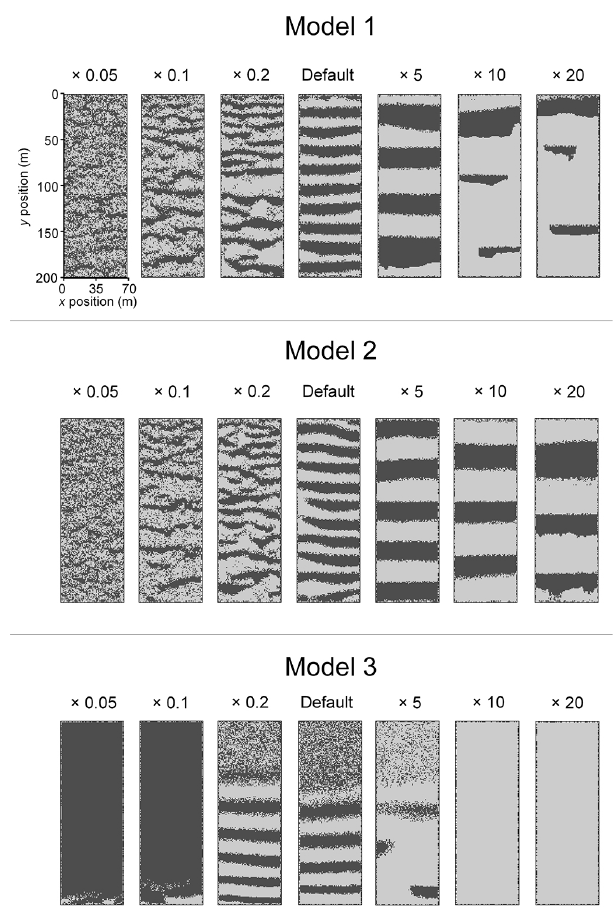
Figure 8. Final micro-habitat maps after 100 developmental steps, showing e ff ects of di ff erent combinations of T hum and T hol (in the case of Model 1, top panel) or K hum and K hol (Model 2, middle panel; Model 3, bottom panel) on pattern geometries in typical model runs. The values of T or K used in each simulation are in- dicated immediately above the maps, and are expressed as a factor of the default values. See main text for full explanation. Light pixels represent hummocks, dark pixels represent hollows. Low values of y represent upslope locations ( y = 0 is the upslope boundary); high values of y represent downslope locations ( y = 200 is the downslope boundary); as such, groundwater flow is generally down the page. All maps have the same horizontal ( x , y ) scale as that shown for the upper-leftmost